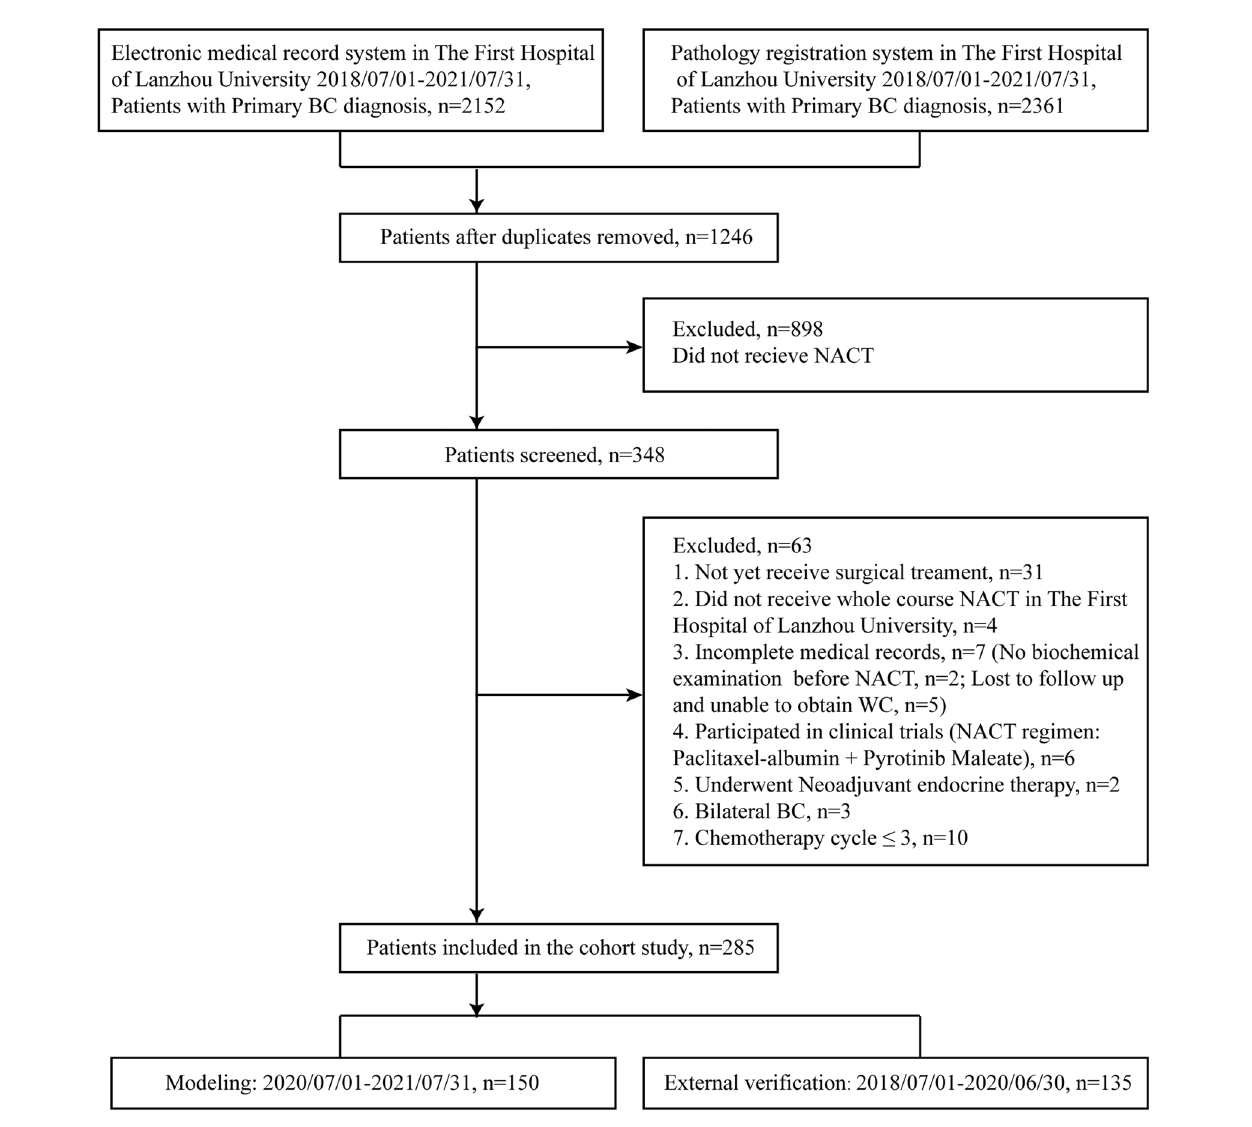
FIGURE 1 | Selection of patients for present study. BC, breast cancer; NACT, neoadjuvant chemotherapy; WC, waist